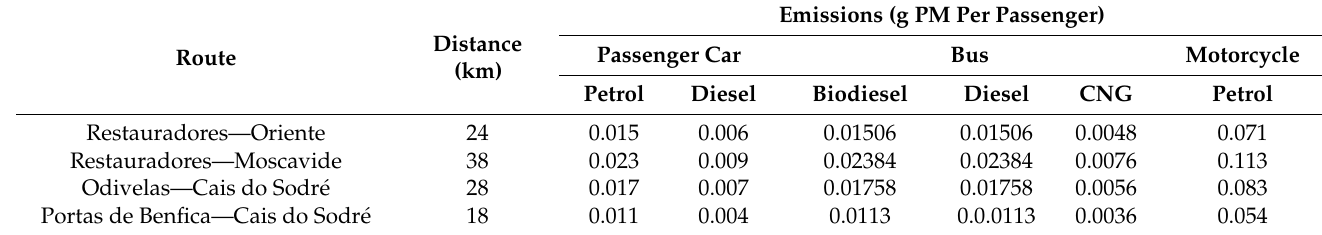
Table 6. PM emissions (g per passenger) of sample motorized transport modes, fuel types, and Euro